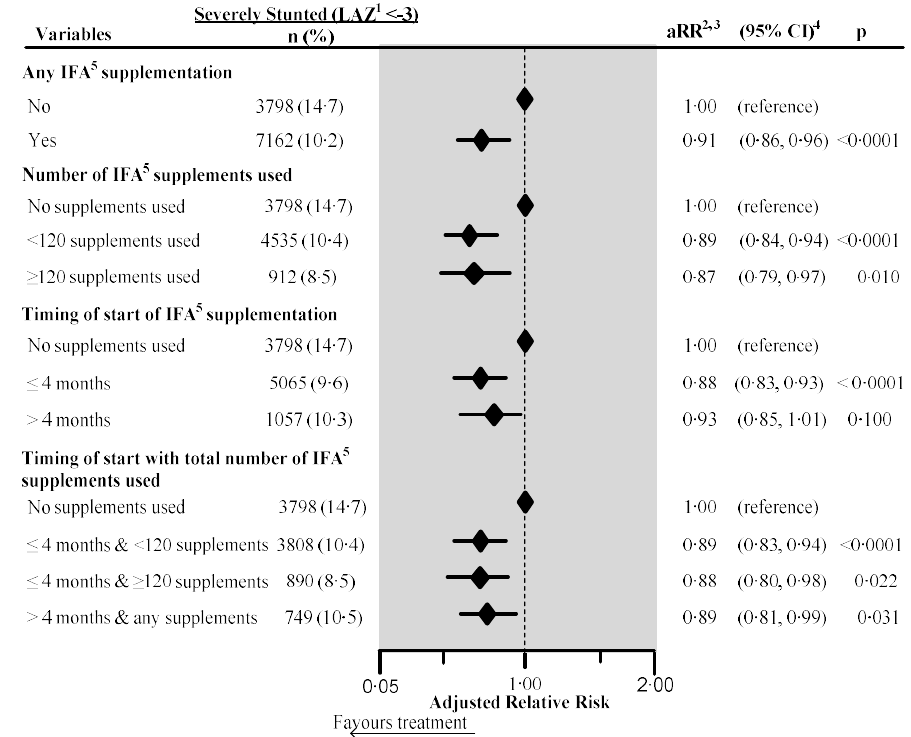
Figure 2. Effect of any iron/folic acid (IFA) supplementation, the number of supplements used, the timing of the start of supplements, and a combination of the timing of start with the number of supplements used on child severe stunting in South Asia, using adjusted Poisson regression. The surveys from Bangladesh and Bhutan did not collect information about the number of IFA supplements used during pregnancy. Hence these survey data were not included in the number of IFA supplementation analyses (n = 4744). Also, we excluded records of mothers from analysis who reported consumption of >240 IFA supplements during pregnancy (n = 85). We also excluded those records where the number of supplements consumed exceeded the number possible when supplementation started between the fifth and ninth months of pregnancy (n = 183). 1 Length-for-Age Z-score 2 Adjusted for country, area of residence, maternal marital status, maternal educational status, fuel used for cooking, source of drinking water, sanitation facilities, pooled household wealth index, maternal age at childbirth, sex of child, the timing of initiation of breastfeeding, age of the child, and child had diarrhea during last two weeks before the interview. Also, we adjusted the model for the duration of recall. 3 aRR: Adjusted relative risk. 4 CI: Confidence interval. 5 IFA: Iron/folic acid.